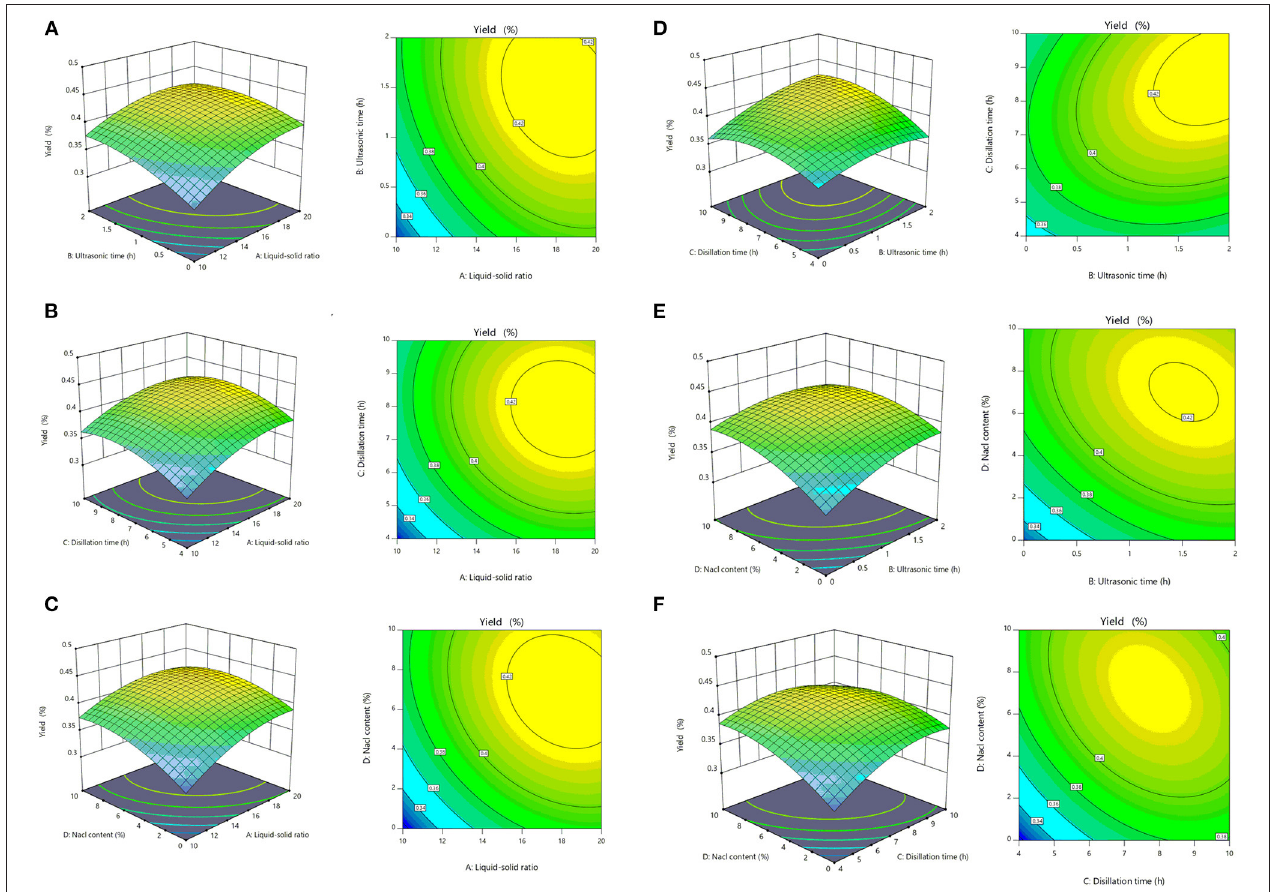
FIGURE 2 | The mutual effects of the response surface plots and contour plots for the extraction yields of essential oils of sunflower receptacles (SEOs). (A) Ultrasound time and liquid–solid ratio, (B) distillation time and liquid–solid ratio, (C) sodium chloride (NaCl) content and liquid–solid ratio, (D) distillation time and